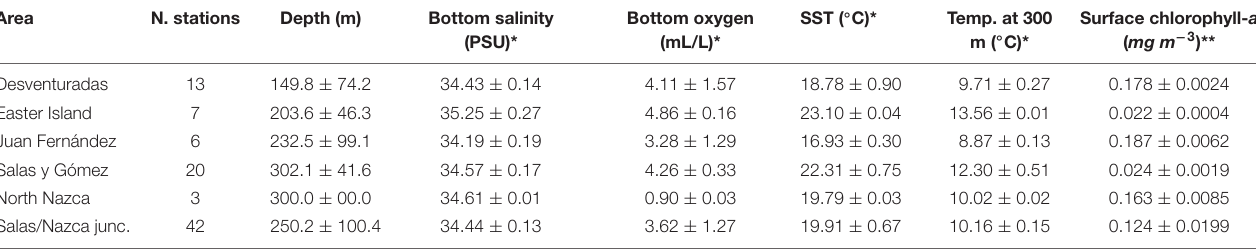
TABLE 1 | Averaged values ( ± standard deviation) of environmental variables at each sampled area. Area N.